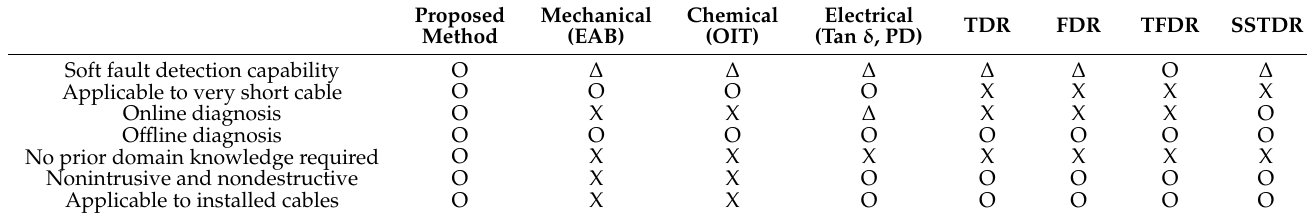
Table 5. Comparison with other fault diagnosis